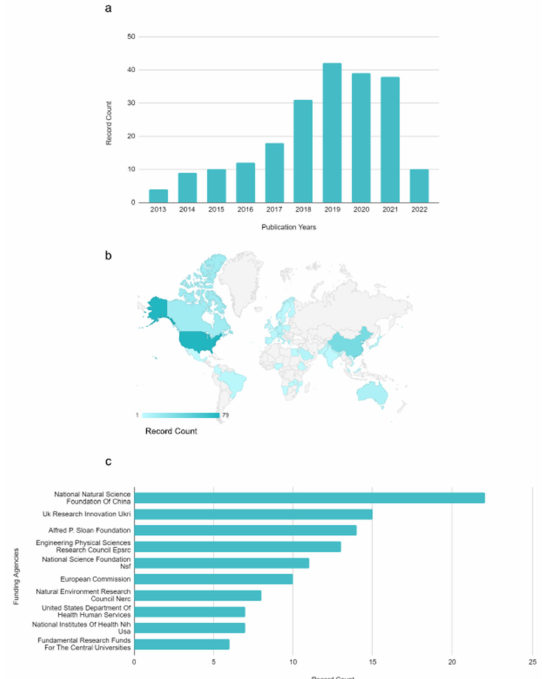
Figure 1. Published papers from 2013 concerning drinking water microbiome, obtained from ISI Web Of Science database. ( a ) Bar chart distribution of published papers by year. ( b ) Geo chart showing the distribution of published papers per country. ( c ) Top ten funding agencies contributing to published papers. Record count: published papers, n =